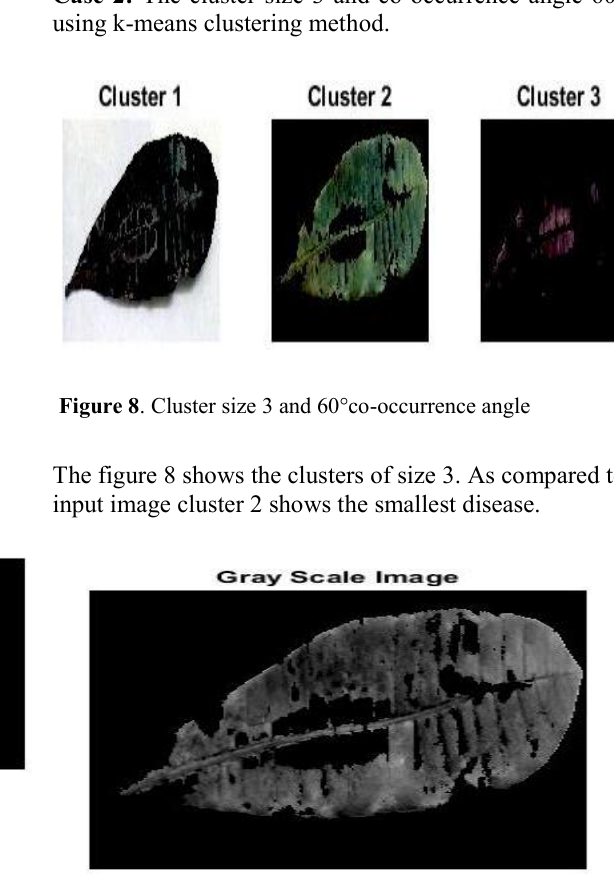
Figure 9. Gray scale image using cluster 2 and 60°co- occurrence angle